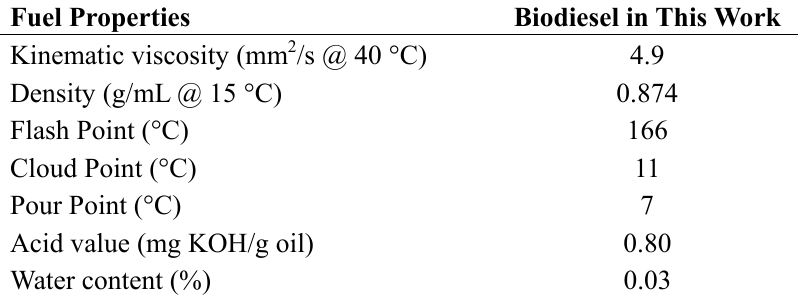
Table 3. The fuel properties of biodiesel derived from waste frying oil